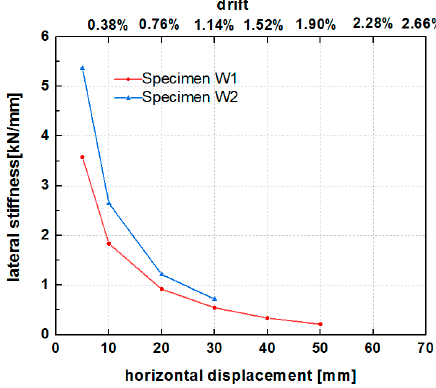
Figure 17. Stiffness degradation curves of specimens W1 and W2.